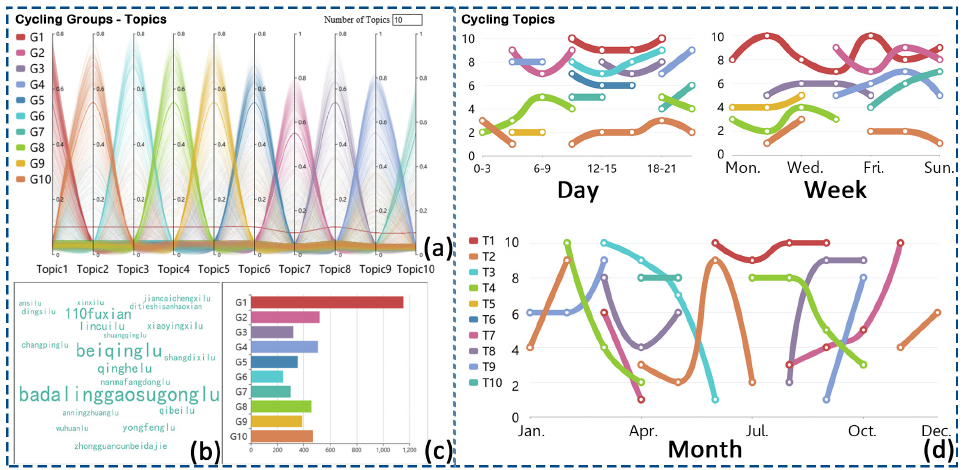
Figure 6. ( a ) Cycling groups and topics. ( b ) Street cloud of cycling topics. ( c ) Size of cycling groups. ( d ) Temporal evolution of cycling topics at different time granularity